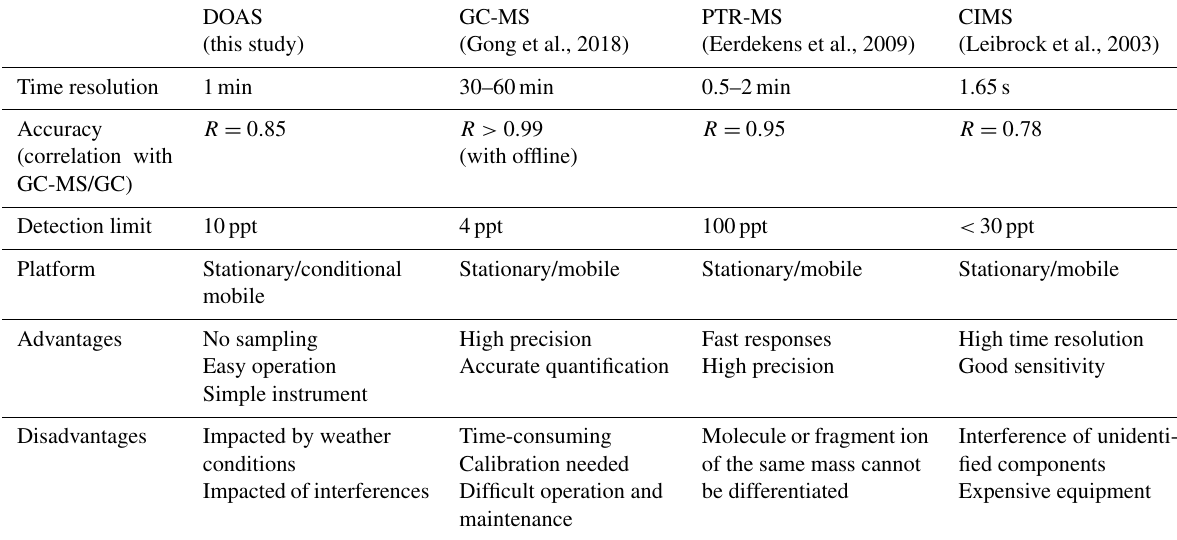
Table 1. Comparison of different online methods for isoprene measurement. DOAS GC-MS PTR-MS (Gong et al., 2018)